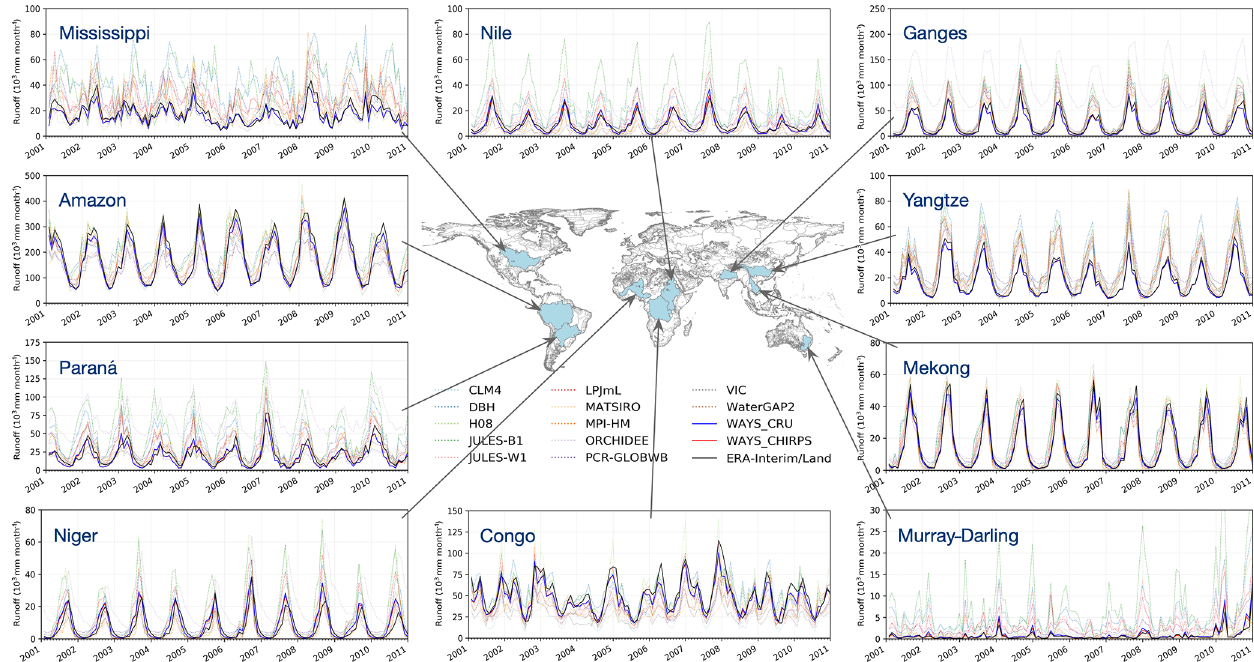
Figure 2. Time series of monthly runoff simulated by WAYS and the ISIMIP2a models, as well as the reference data. The basins highlighted in the world map indicate the selected catchments for model evaluation. The solid lines in blue and red indicate the WAYS simulations with two different RZSC products. The solid line in black indicates the ERA-Interim/Land data, and dashed lines represent the ISIMIP2a model simulations. In some plots, the red line is not visible and is covered by the blue line due to the small differences between the two WAYS runs. WAYS is calibrated using composite monthly runoff data, while the ISIMIP2a models are not calibrated for the